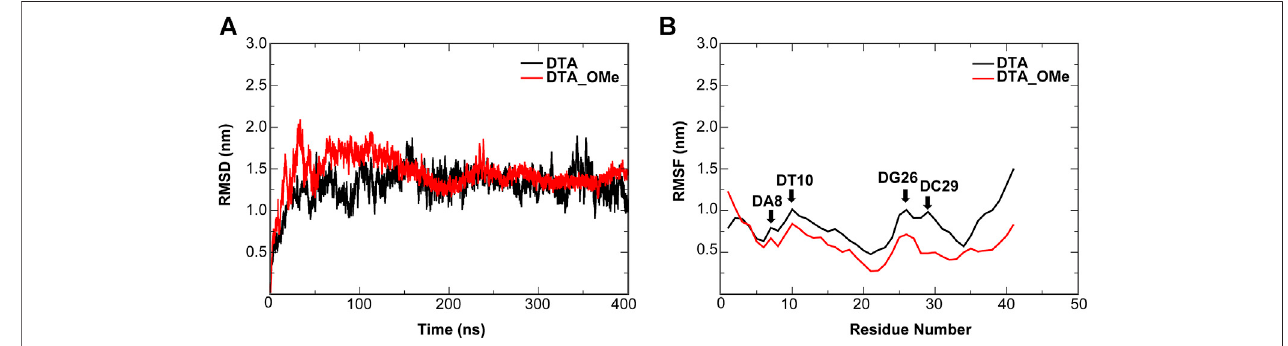
FIGURE 5 | Dynamic trajectory analysis of the DTA and DTA_OMe aptamers. (A) RMSD (B) RMSF. The nucleotides with the large changes of RMSF before and after modi fi cation are labeled.